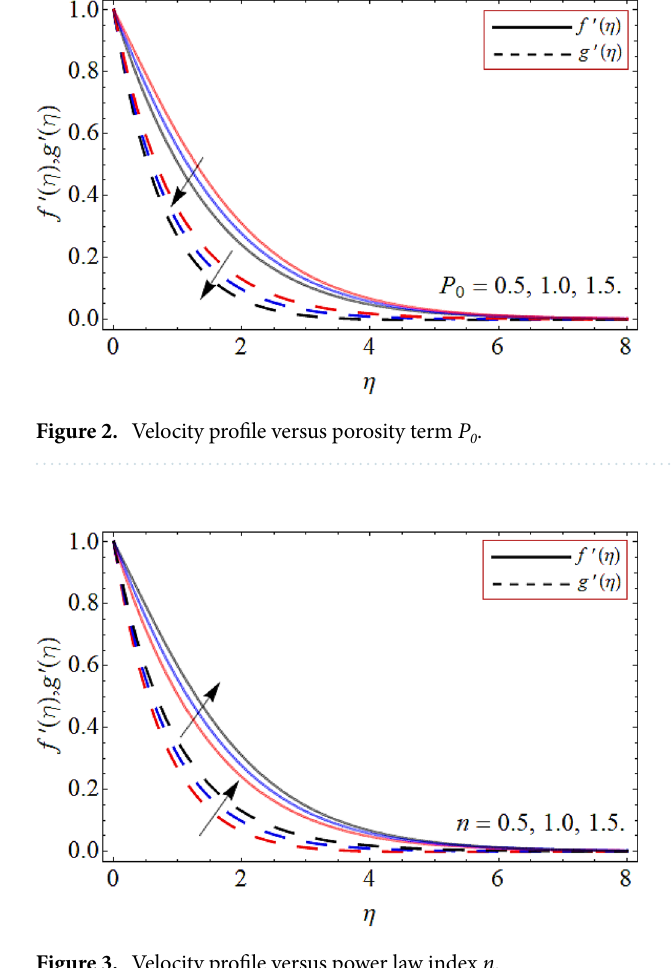
Figure 3. Velocity profile versus power law index n .